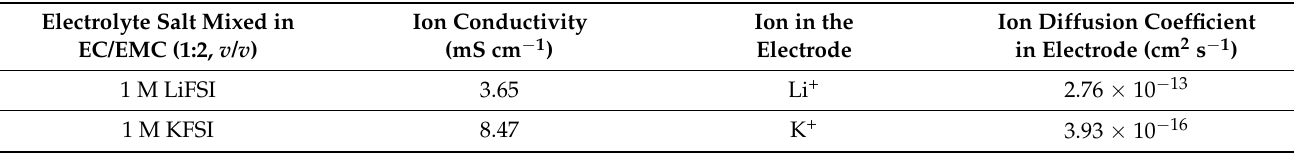
Table 1. K + and Li + ion conductivities in 1 M KFSI and 1 M LiFSI electrolytes, and K + and Li + ion diffusion coefficients in K-MA electrode from Figure 2.